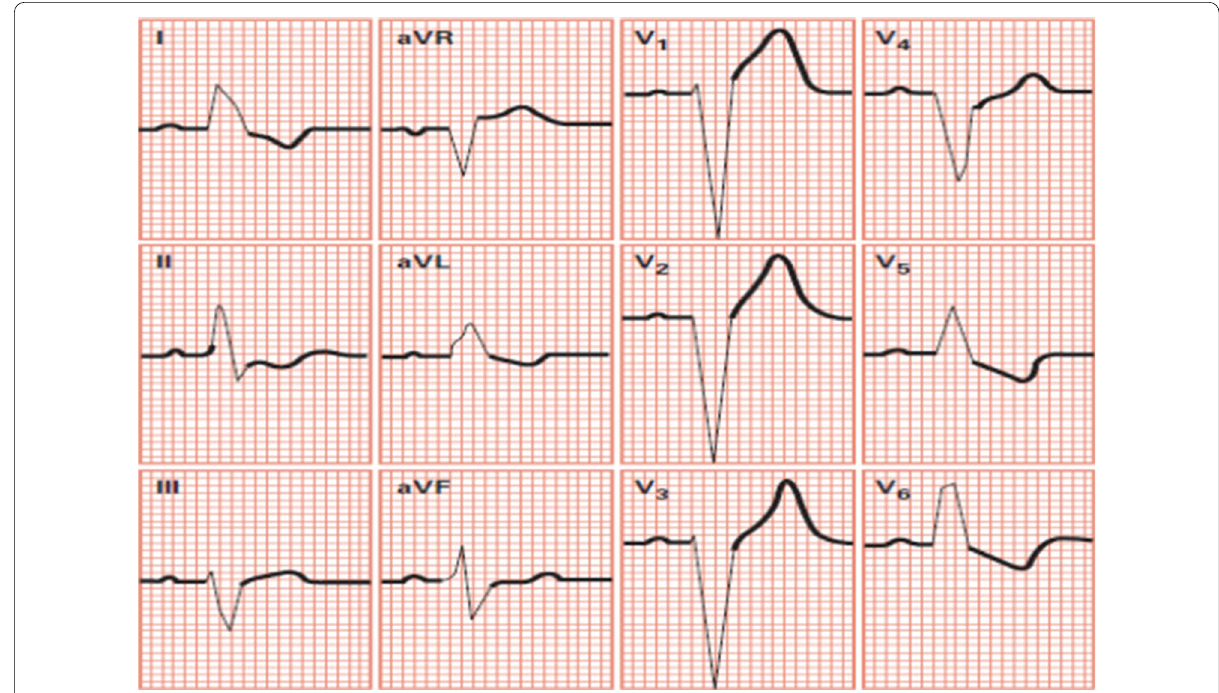
Fig. 2 Morphology of LBBB arrhythmia: Figure shows various morphologies of LBBB arrhythmia with different leads